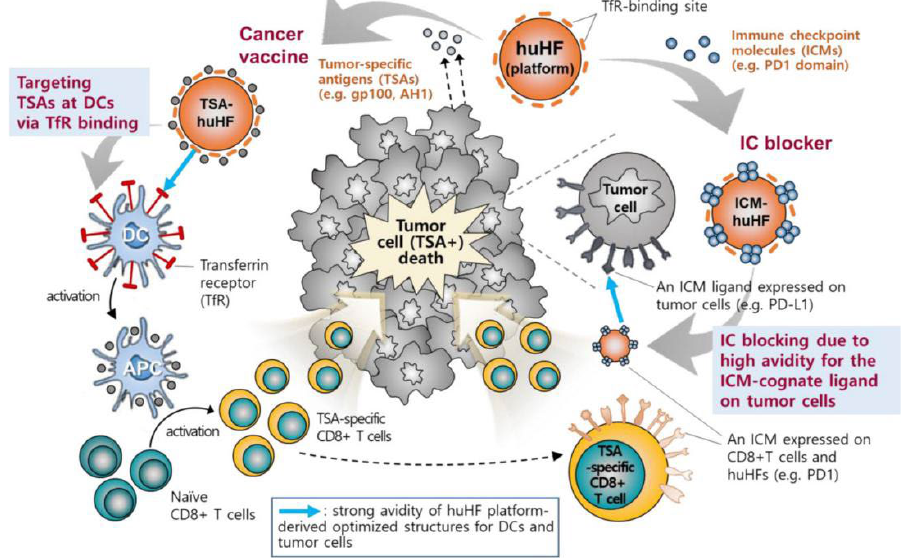
Figure 1. The mechanism of ferritin-based vaccines [41].